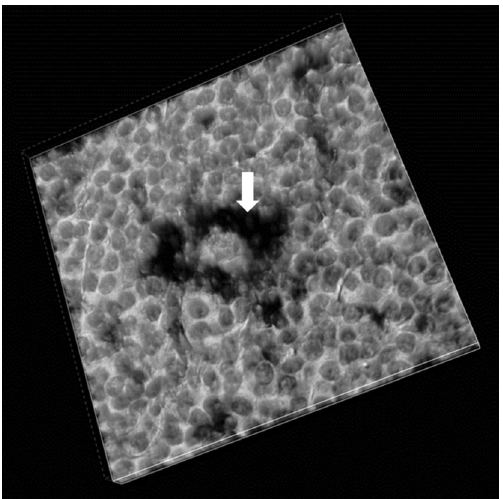
Figure 3. Confocal microscopy in light field from a case with intense TIGIT score. The black stained TIGIT+ lymphocytes (arrow) surround the HRS cell creating a fence against the immune